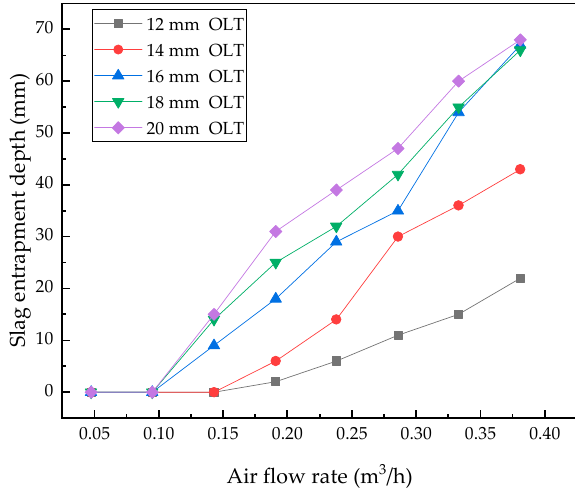
Figure 6. The influence of air flow rate to entrapping depth in the water model with a single porous plug.